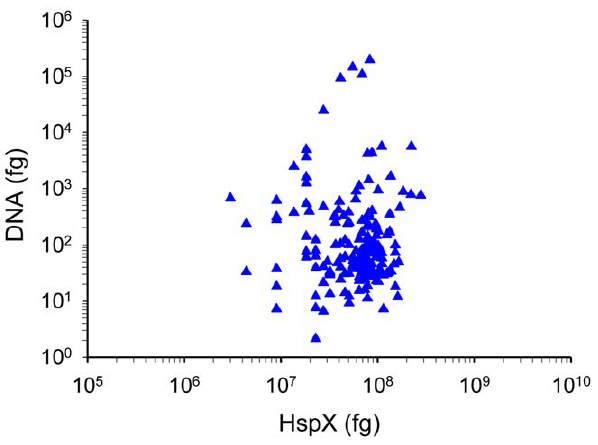
Figure 6. Comparison of M.tb DNA vs. antigen amount in CSF. A representative graph of HspX is shown. All other antigens showed a similar pattern (Figure S3). Starting amounts of DNA and antigen in 5 m l CSF were quantitated by qPCR and ELISA, respectively.